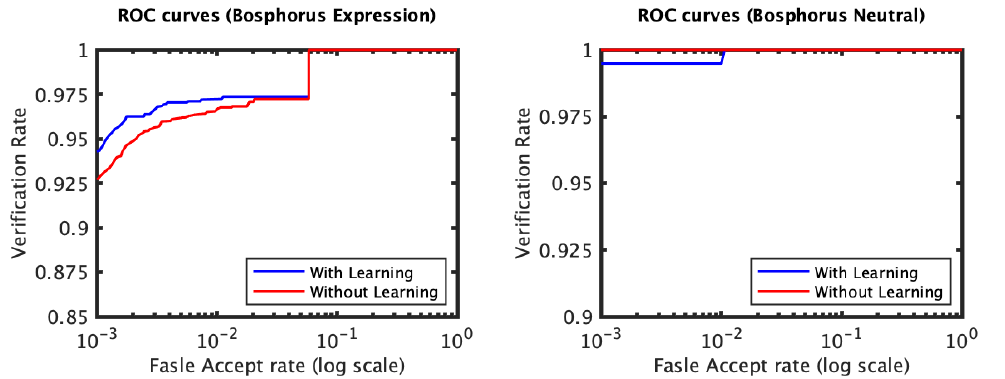
Figure 8. The ROC curves of the Bosphorus dataset (RAIK